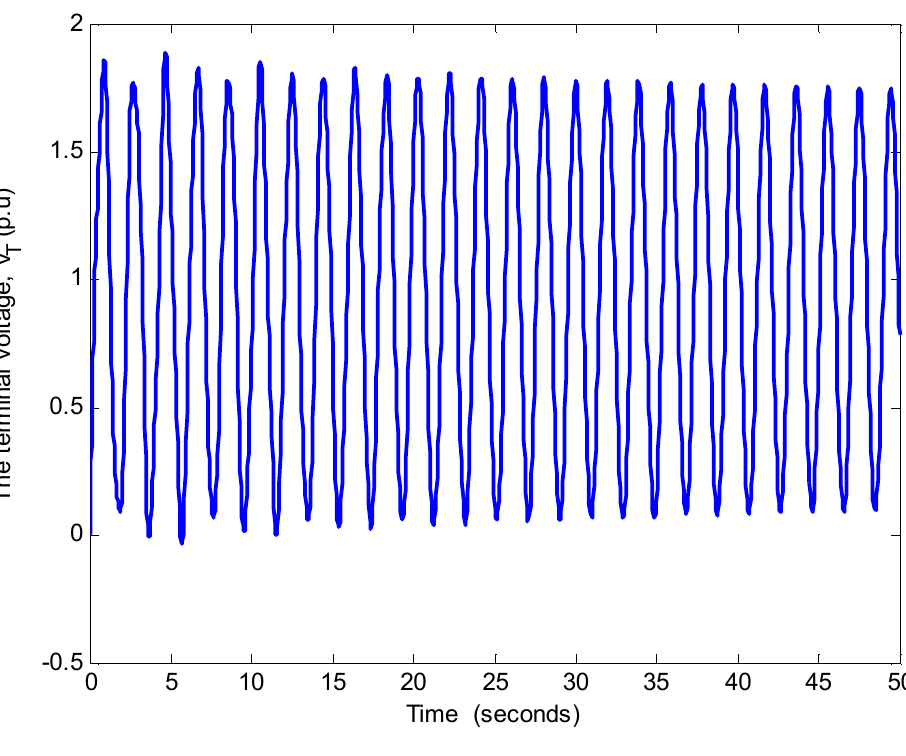
Figure 20. The terminal voltage with a 0.4 s time delay.